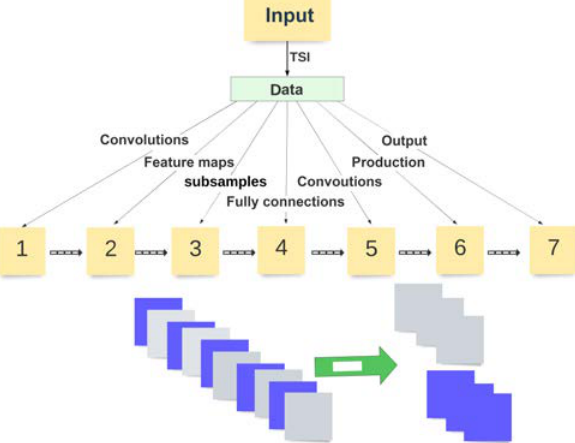
Fig. 5 Algorithmic steps of the SVD-ICA model. Fig. 6 CNN